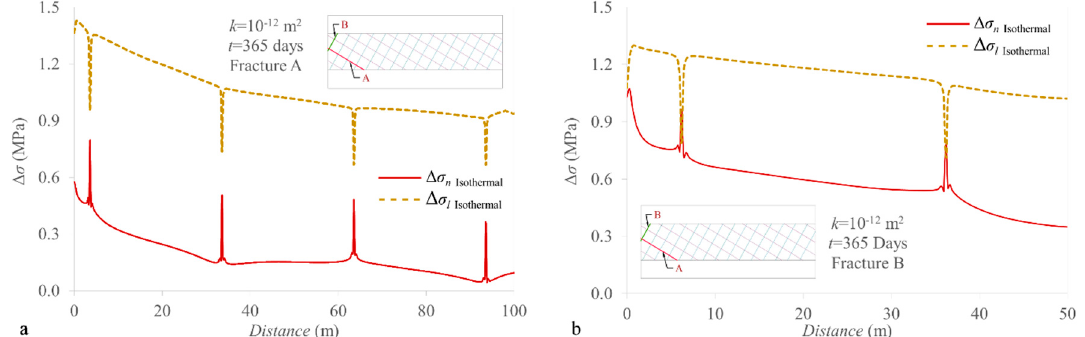
Figure 9. Total stress changes in the normal and longitudinal directions for isothermal injection along fractures ( a ) A and ( b ) B after 1 year of injection for a fracture with intrinsic permeability of 10 − 12 m 2 .